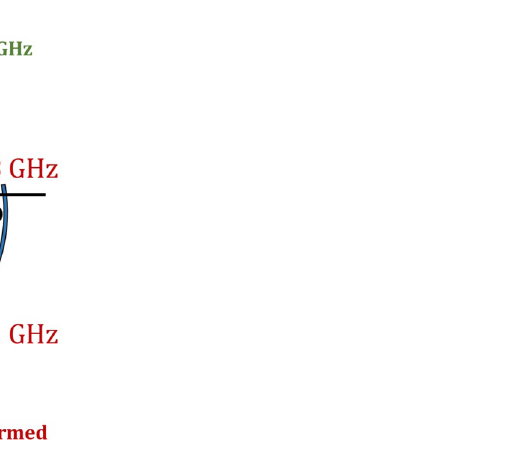
Figure 13. Predicted frequencies of grating